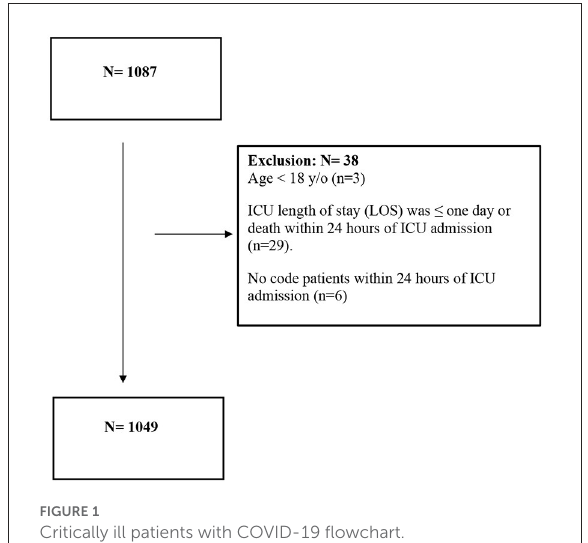
FIGURE1 Critically ill patients with COVID-19